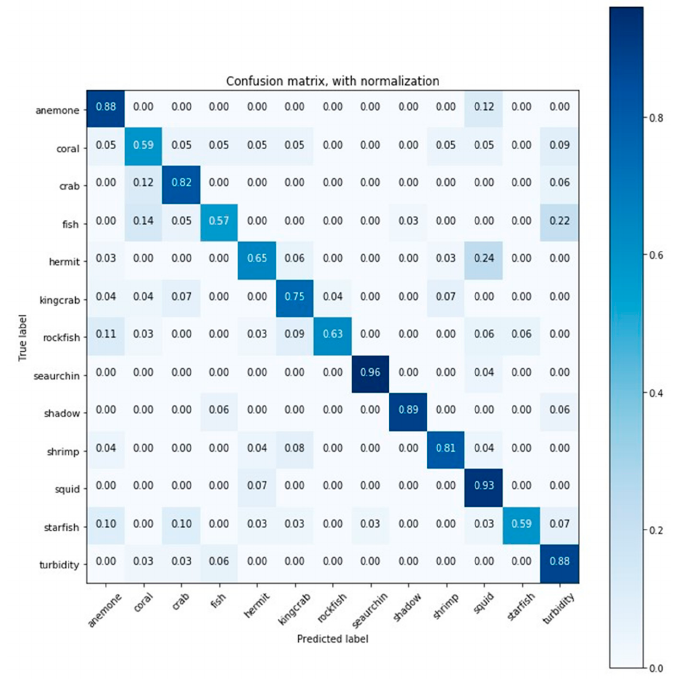
10 of 27 Table 4. Accuracy and area under the curve (AUC) values with test dataset and training time obtained by different models. Type of approach